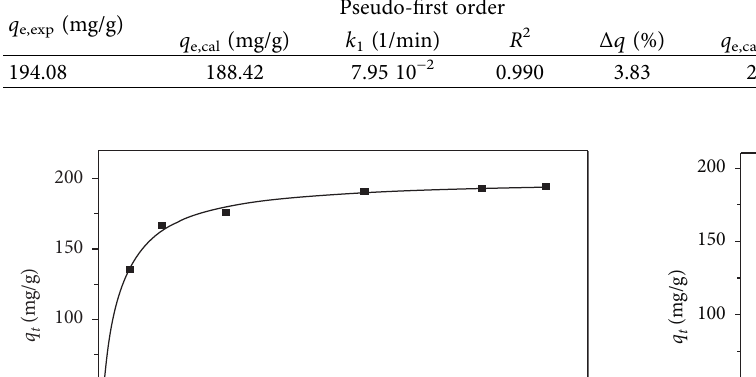
Table 1: Pseudo-first-order and pseudo-second-order kinetic parameters ( C q e,exp (mg/g)